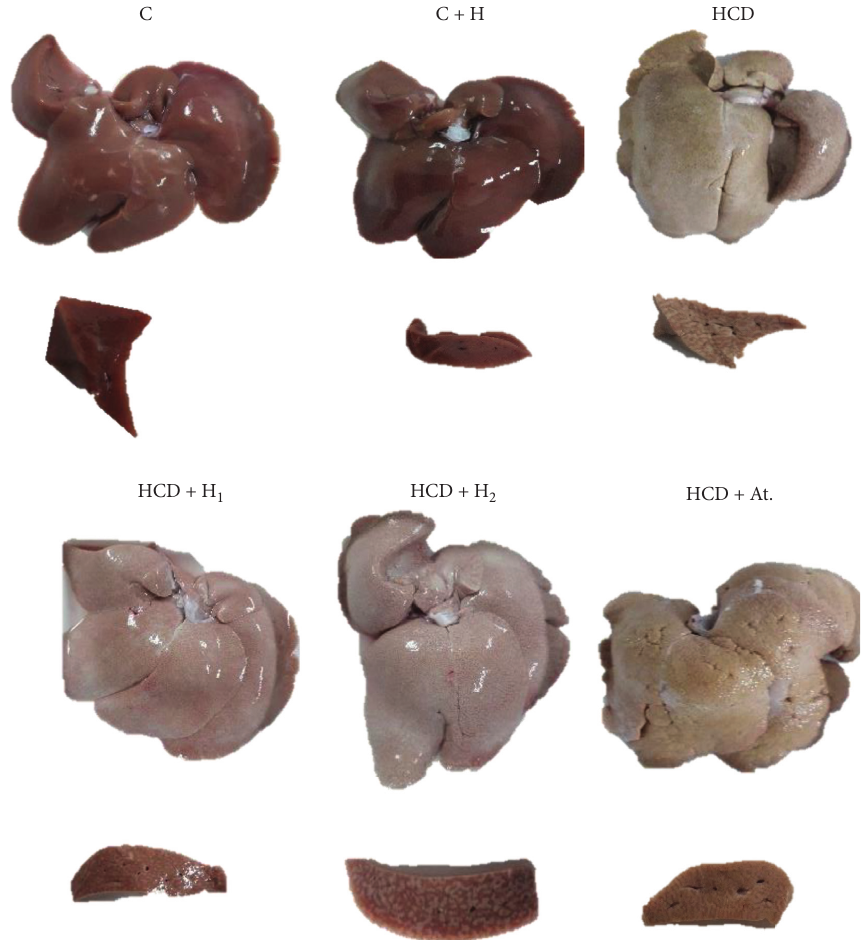
Figure 2: Macroscopic features and cut surface of a representative liver from each experimental